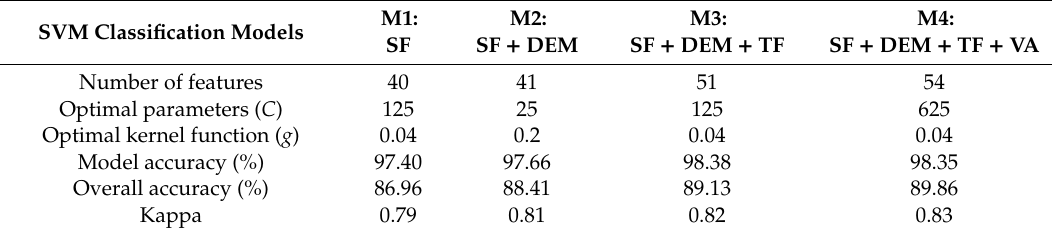
Table 5. Confusion matrix of M4 (SF + DEM + TF + VA). Each row designates the classification result, and each column designates the field-based validation